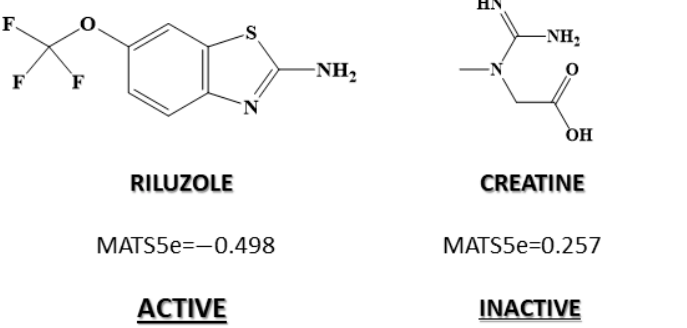
Figure 2. Most relevant descriptors in determining the chemical–mathematical pattern related to anti-ALS tested in clinical trials by DF clin .